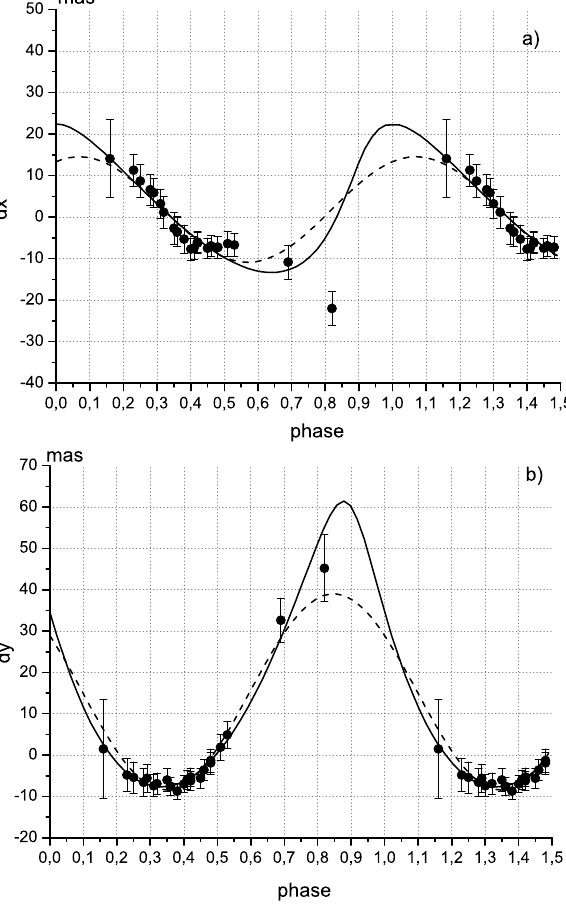
Fig. 2. ADS 9173. Comparison of the astrometric orbit Aab with ob- servations — dx(phase)(a) and dy(phase)(b). Phase=0 corresponds to T 0 = 2000.0. Notations are as follows: deviations are black cir- cles, solid line is the ephemeris of the orbit (e=0.5), dashed line is the ephemeris of the circle orbit